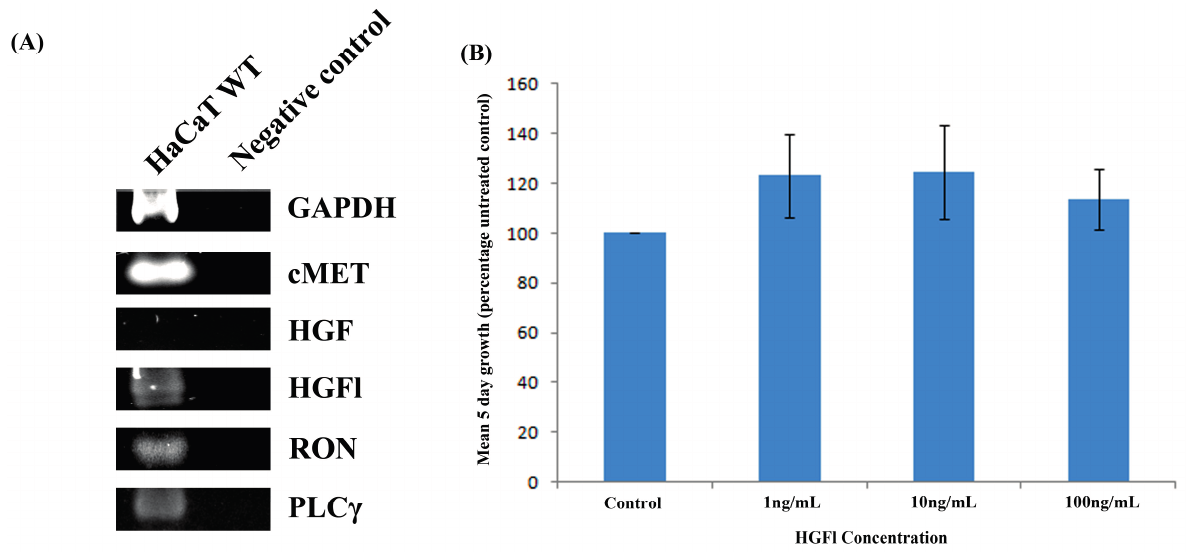
Figure 3. Expression analysis in human HaCaT keratinocytes and impact of HGFl on cell growth rates. HaCaT cells displayed strong expression for the HGF receptor cMET whilst not expressing HGF itself. Moderate expression was observed for HGFl, RON and PLC γ ( A ) Treatment of HaCaT keratinocytes with rhHGFl over a range of concentrations did not significantly impact on cell growth rates ( B ) Representative PCR images or Mean values ± SEM